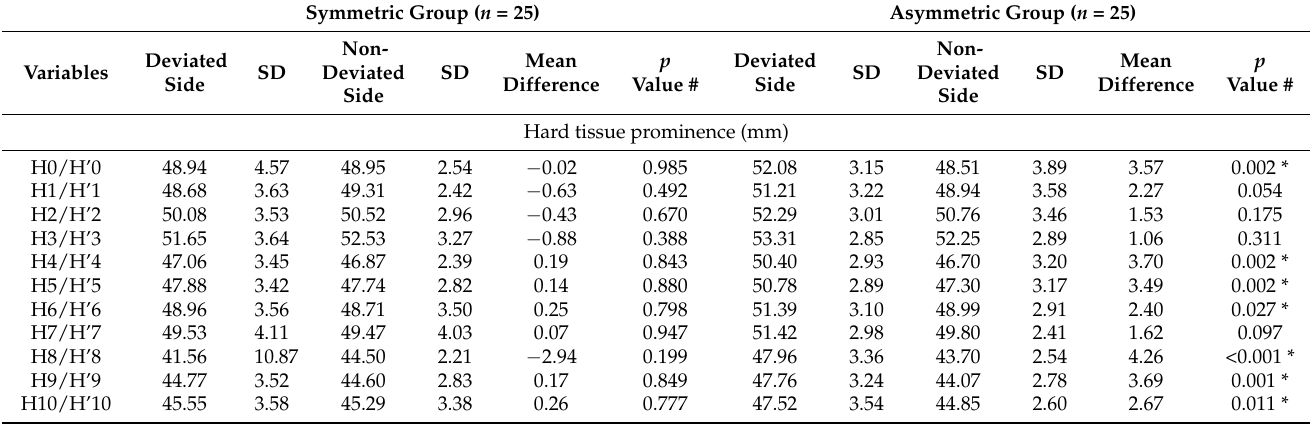
Table 3. Comparison between deviated and non-deviated sides in the symmetric and asymmetric